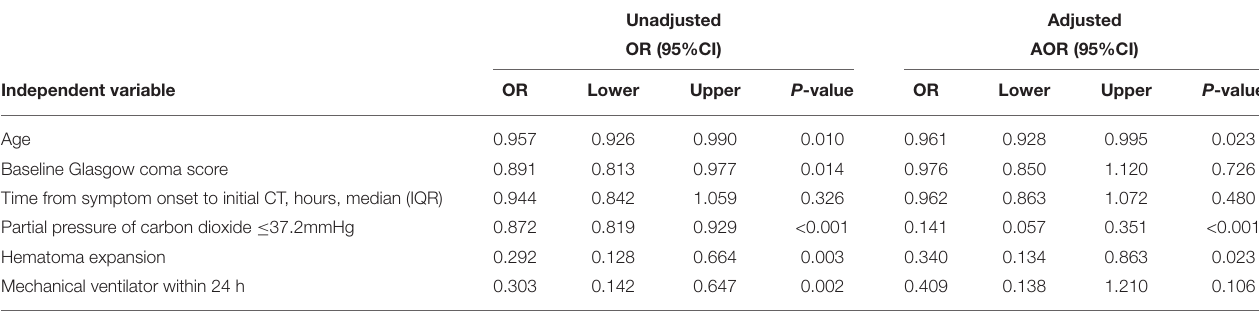
TABLE 3 | Predictors for ISs of spontaneous intracerebral hemorrhage in multivariate